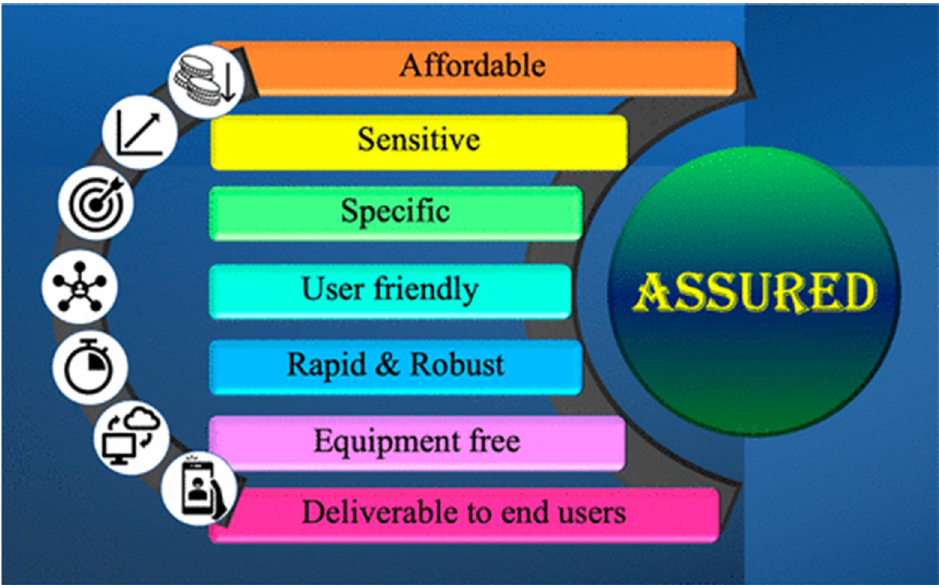
Figure 7. Schematic diagram representing the “ASSURED” guidelines featuring point-of-care devices. Reproduced with permi ssion from [39], Creative Commons.